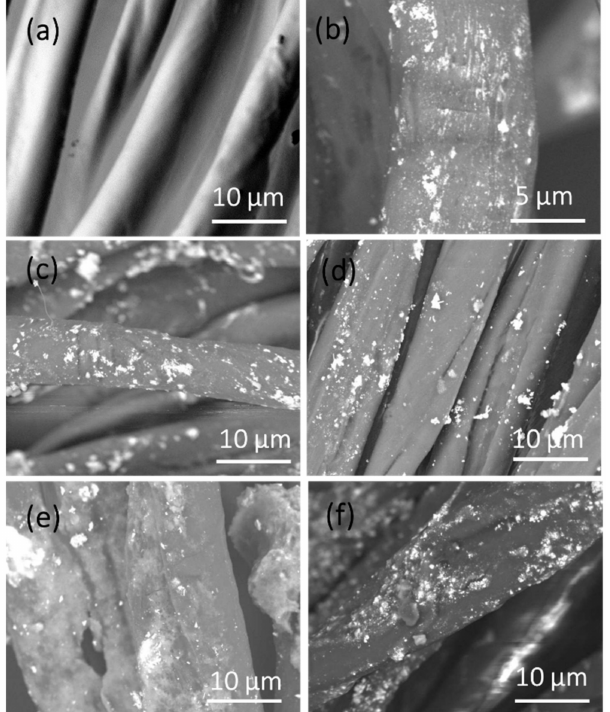
Figure 6. Representative scanning electron microscopy (SEM) photographs of the cotton gauze samples: ( a ) blank cotton gauze, ( b ) Ag- cotton gauze, ( c ) 2.5%HAp-Ag- cotton gauze, ( d ) 5%HAp- Ag-cotton gauze, ( e ) 5%HAp-cationized cotton gauze; ( f ) 5%HAp-anionic modified cotton